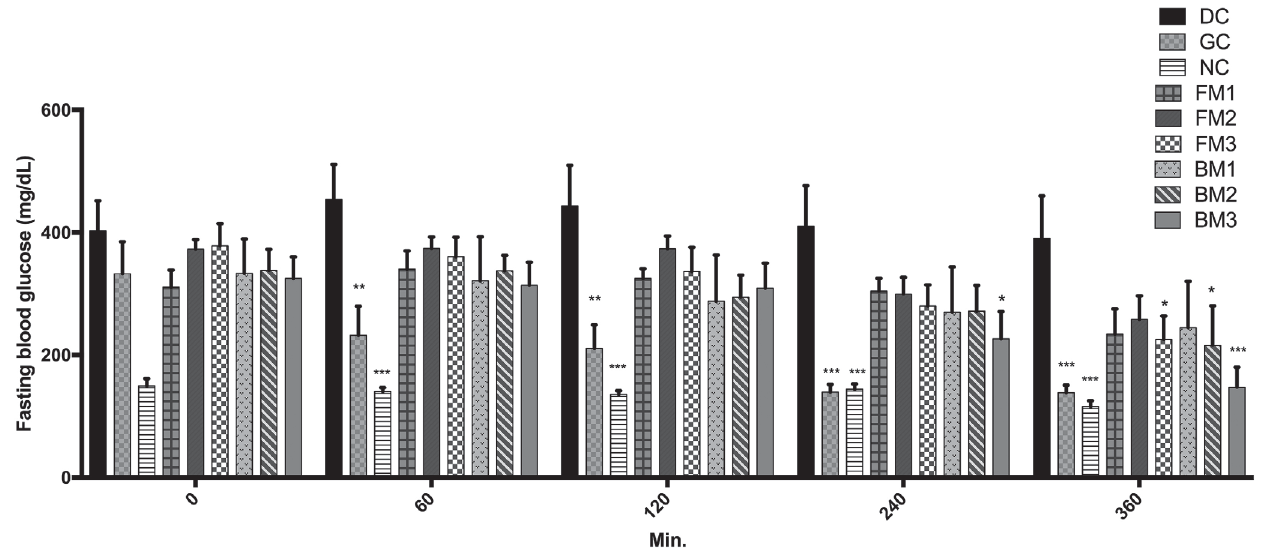
FIGURE 1 - The hypoglycemic effect of fruits-buds of C. ovata var. palaestina ’s methanol extracts. Values are presented as the mean±SEM. DC: diabetic control, GC: glibenclamide-control, NC: normoglycemic-control, FM1: fruit methanol 100 mg/kg, FM2: fruit methanol 300 mg/kg, FM3: fruit methanol 500 mg/kg, BM1: bud methanol 100 mg/kg, BM2: bud methanol 300 mg/kg, BM3: bud methanol 500 mg/kg. * P <0.05, ** P <0.01, *** P <0.001; significant difference from diabetic-control (DC)